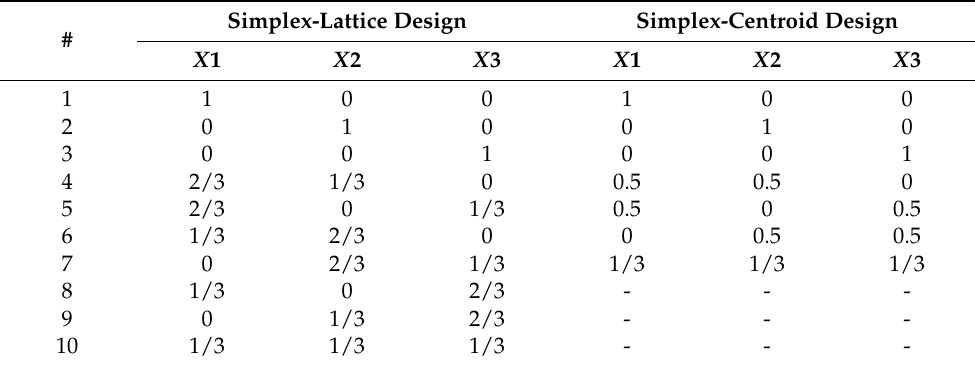
Table 1. Experimental points (blends of the components X 1, X 2, X 3) for a special cubic model according to the simplex-lattice or the simplex-centroid designs. Simplex-Lattice Design #